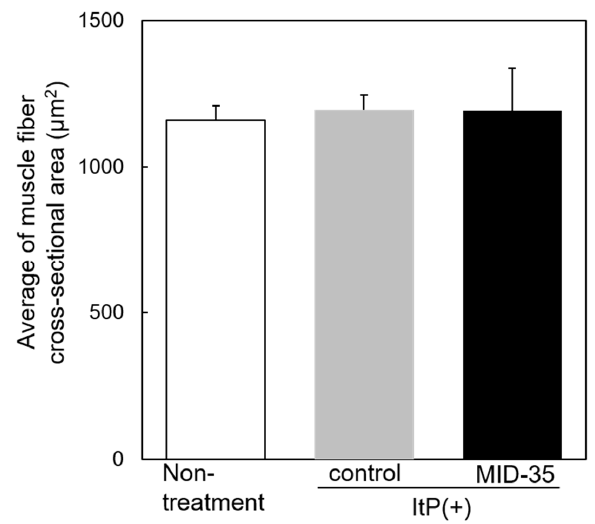
Figure 4. Effect of the delivery of MID-35 by ItP on muscle fiber cross-sectional area: The cross- sectional areas of the muscle fiber shown in Figure 3 were calculated with the image analysis software ImageJ. The columns of white, gray and black are the cross-sectional areas of muscle collected from non-treated mice, control ItP/PBS-treated mice and ItP/MID-35-treated mice, respectively. The values are shown as means ± SD obtained from five different images of muscle cross-sections.